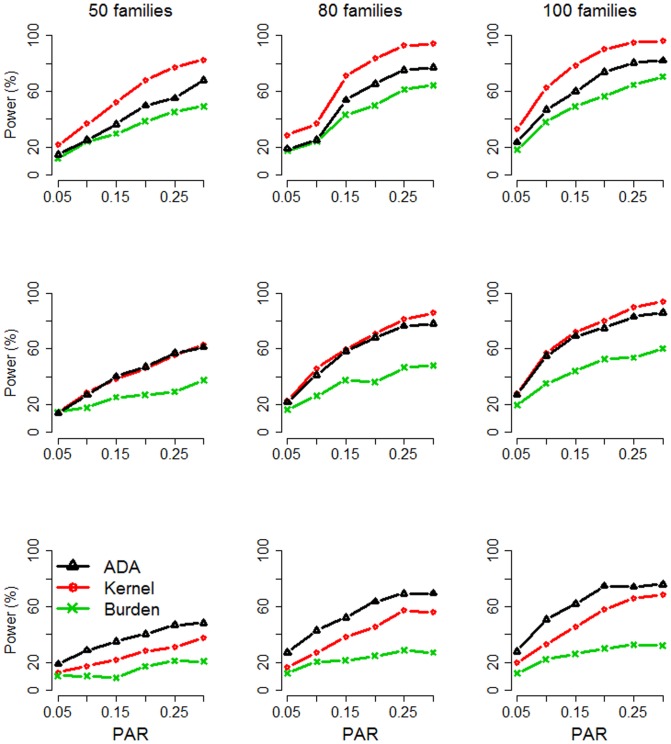
Power Comparison for dichotomous traits.The figure shows the empirical power given the significance level of 0.05. Top row: 50 variants included in the tests; middle row: 100 variants; bottom row: 150 variants. The x-axis is the overall population attributable risk (PAR) for all causal loci, whereas the y-axis is the power.